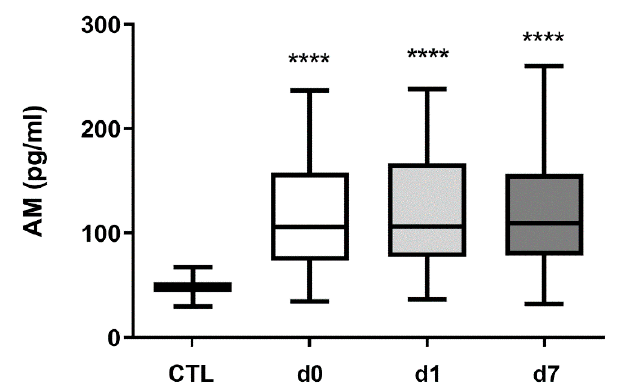
Figure 1. Circulating AM levels increase in hemorrhagic stroke patients. AM levels were measured by RIA in 50 healthy volunteers (CTL) and in 64 hemorrhagic stroke patients. In patients, blood samples were taken on admission (d0), 24 h later (d1), and at hospital discharge (d7). Box plots represent the interquartile range with the median as a horizontal line. Whiskers encompass the maximum and minimum values of the population. ****: p < 0.0001, compared to CTL. The optimal cutoff for AM to differentiate between stroke patients and healthy con- trols, according to Youden’s J statistic, was 69.0 pg/mL (J = 0.80). A receiver operating characteristic (ROC) curve using this cutoff value shows an area under the curve (AUC) of 0.89, with 80.0% sensitivity and 100% specificity ( p < 0.0001) (Figure 2).